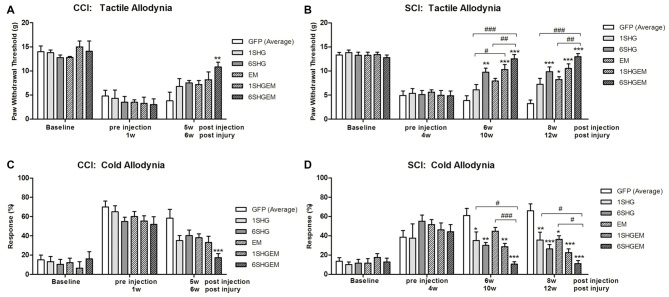
Comparison of the analgesic effect of singe and compound gene constructs at 5 weeks post injection in CCI animals (A,C) and 6 and 8 weeks post injection in SCI animals (B,D). In both groups and both pain modalities, no differences were observed at the baseline or pre-injection time points. In CCI group at 5 weeks post injection the effect of 6SHG/EM1 was significantly different from GFP controls (ANOVA; **p < 0.01). In SCI group all treated animals demonstrated reduction in hypersensitivity with significant differences compared to control GFP groups as well as inter-treatment differences. The effect was observed up to 8 weeks post injection of the constructs with 6SHG/EM1 as the most efficient construct reducing pain-like behavior (ANOVA; *p < 0.05, **p < 0.01, ***p < 0.001 vs. GFP, #p < 0.05, ##p < 0.01,  ###p < 0.001 between treatments).